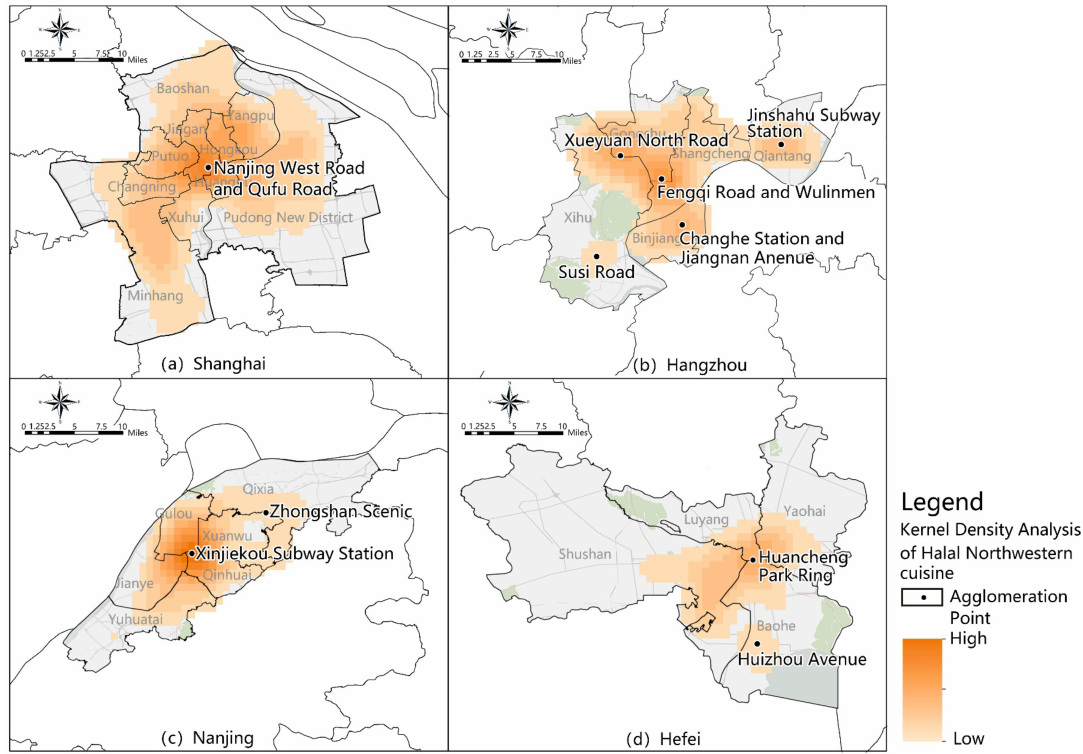
Figure 13. Kernel density analysis of Halal Northwestern cuisine in the main urban areas of the four central cities in the